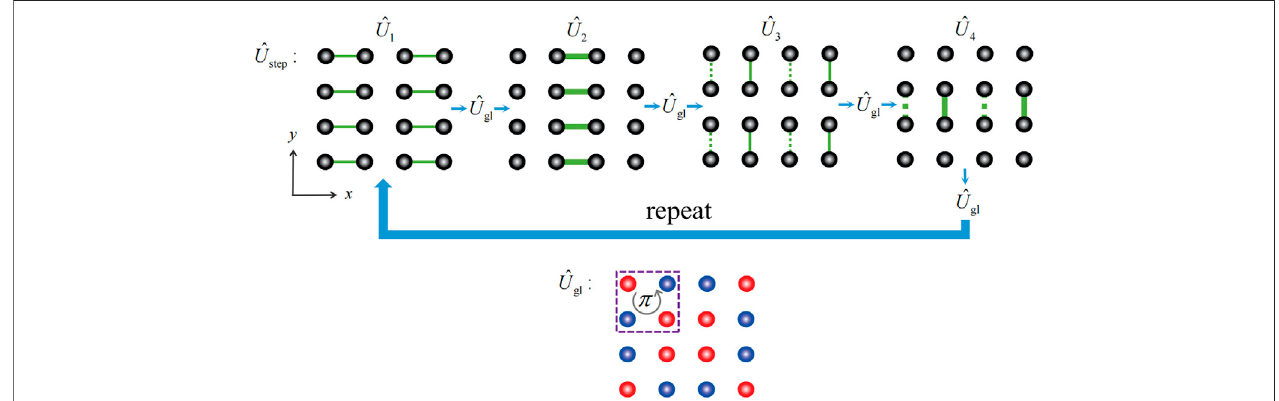
FIGURE 1 | Up: Schematic of the eight-step non-unitary coinless DTQW in a two-dimensional lattice. For the four unitary substep operators ^ U i in Eqs 6 – 9 , the couplings between the different lattice sites are represented by the different thicknesses of the green lines. The two kinds of green lines with different thicknesses represent two types of coupling strengths J 1 (thin) and J 2 (thick), respectively. And the dashed green lines in the y direction indicate the required phases of ± π in the couplingprocess.Bottom:Schematicofthenon-unitarysubstepoperator ^ U gl of Eq.12 .Thecolorofred(blue)indicatestheon-sitegain(loss).Duetotheemergent phases in the y direction, a π - fl ux will be induced when a walker goes through a closed loop of four sites